Question: Sum up the contents of this chart in one sentence.
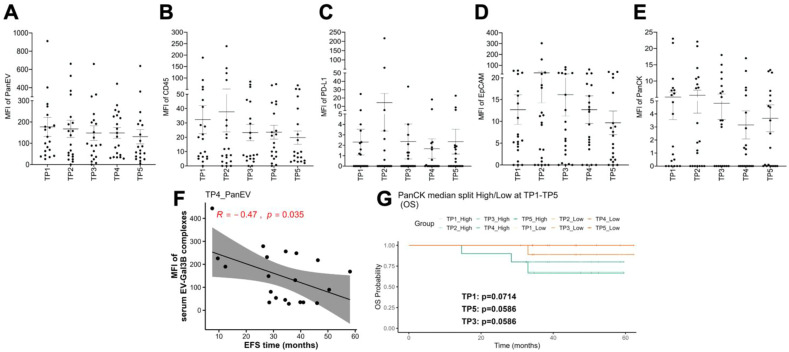
Answer: (A–E) Mean fluorescence intensity (MFI) of different surface markers across all patients and time points (TP1–TP5). (F) Correlation analysis of PanCK + -EXÖBead complex at TP4 with EFS (p = 0.035). (G) Kaplan–Meier analysis of OS based on PanCK + -EXÖBead complex at TP1–5 for high and low MFI values at individual time points.